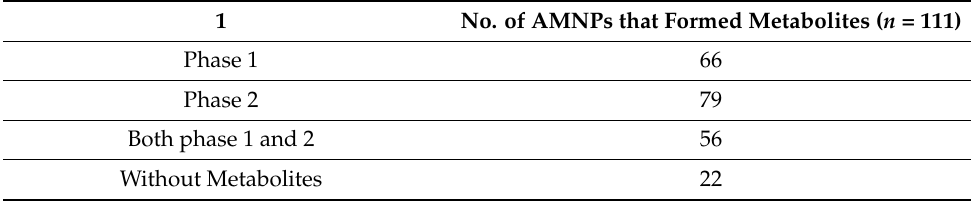
Table 2. Prediction of phase 1 and 2 biotransformations of